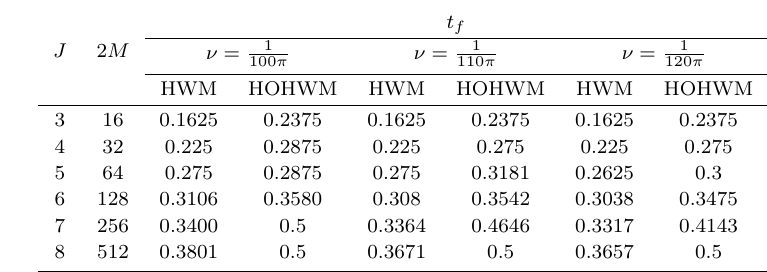
Table 2. Results for the Burgers’ equation: maximal time t f at which the numerical solutions deviates from the exact solution less than 10 − 3 against the resolution parameter J with initial conditions (5.2) and boundary conditions (4.8) ( x ∈ [0 , 1], t ∈ [0 , 1], ν = 1 , 1 , 1 ). 100 π 110 π 120 π